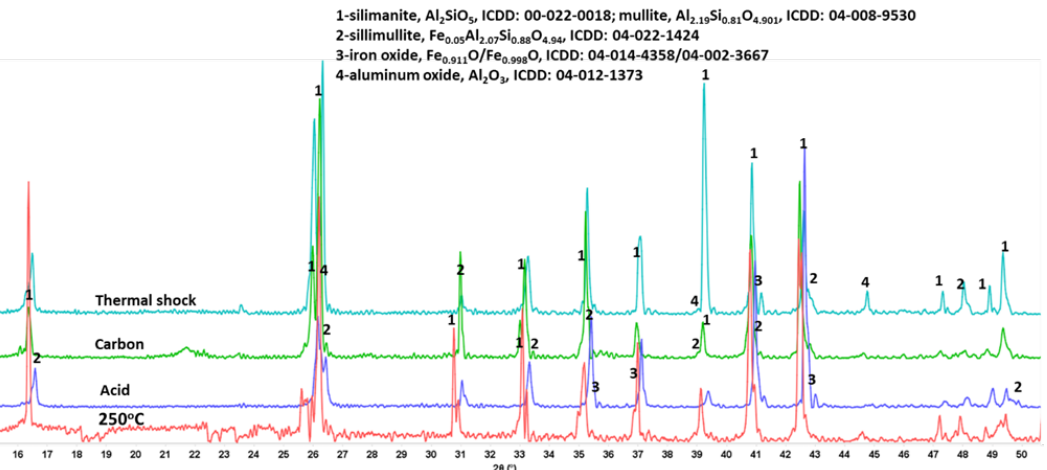
Figure 27. XRD patterns of aluminum oxide samples after the autoclaving at 250 °C, acid-, alkaline carbonate-, and thermal shock tests.